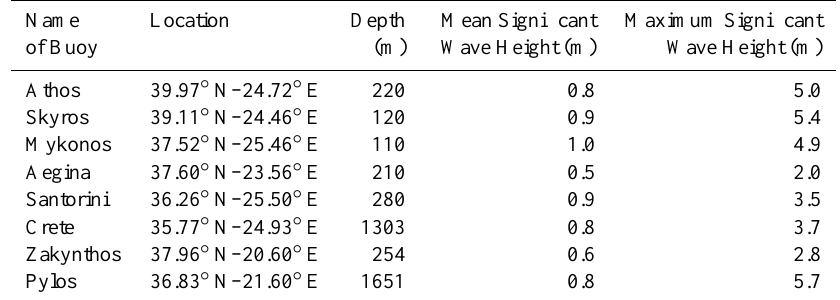
Table 1. Characteristics of the buoys used in this study. The mean significant wave height and the maximum wave height are referred to the 1-yr period from 1 September 2010 up to 31 August 2011.